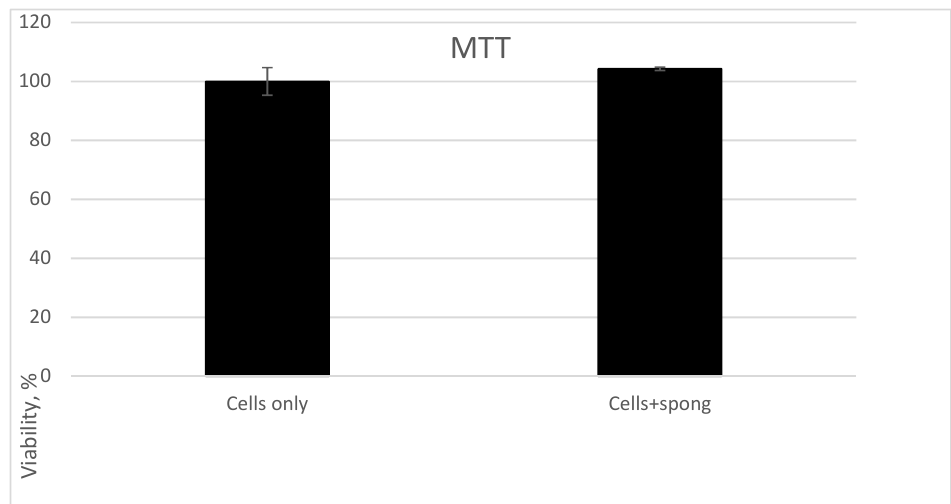
Figure 8. MTT test. No difference in cell viability between control (Cells only) and probe (Cells + Spong) was detected by MTT test.